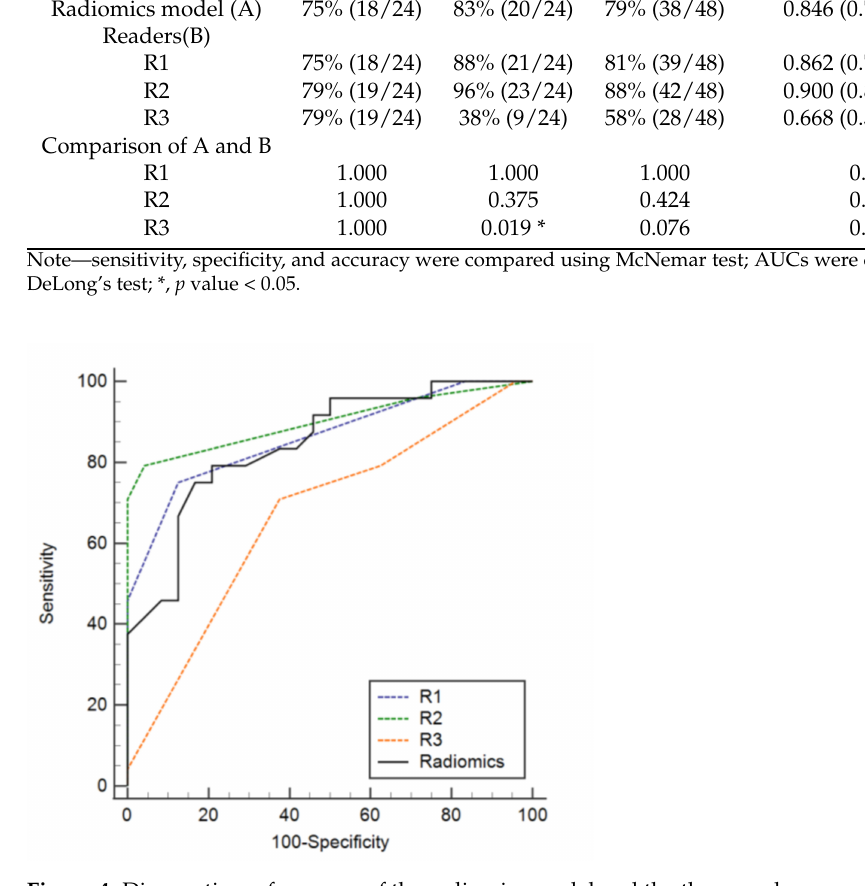
Figure 4. Diagnostic performance of the radiomics model and the three readers.